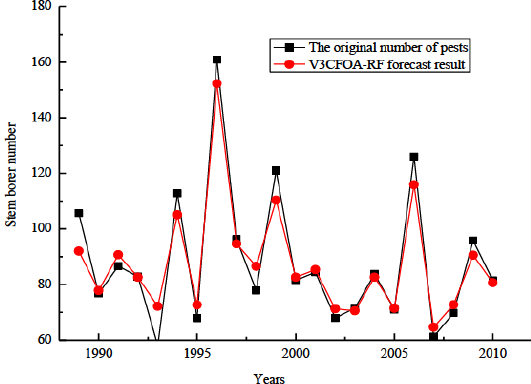
Figure 5: The prediction results of V3CFOA-RF based on the training set